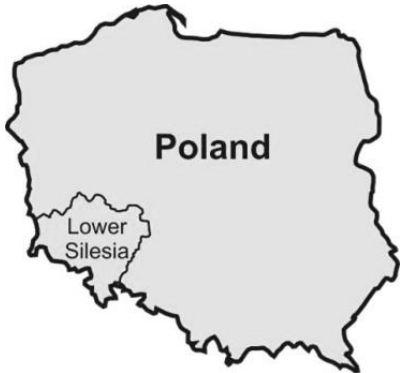
Figure 1. Map of Poland with the research area (Lower Silesia) marked.